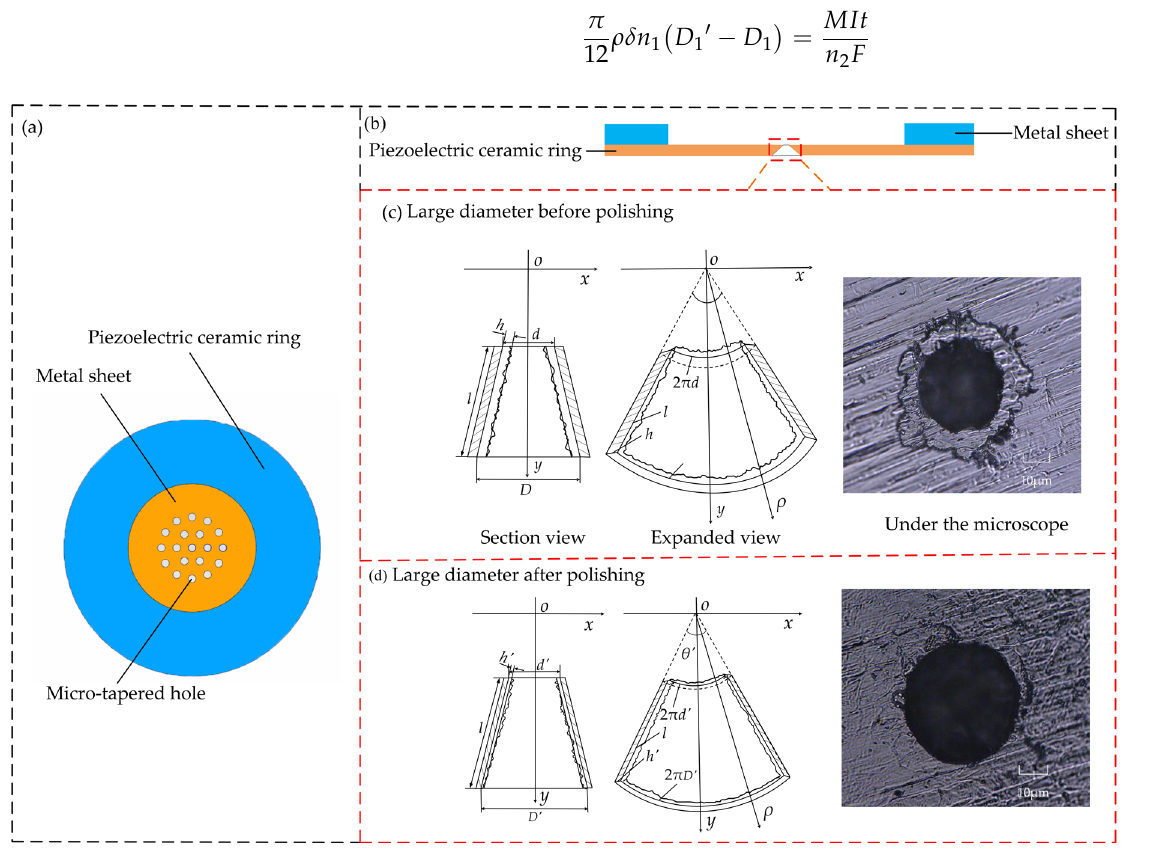
Figure 1. Structural drawing of the atomization sheet: ( a ) Vertical view; ( b ) Side view; ( c ) Large end of a micro-tapered hole before polishing; ( d ) Large end of a micro-tapered hole after polishing.